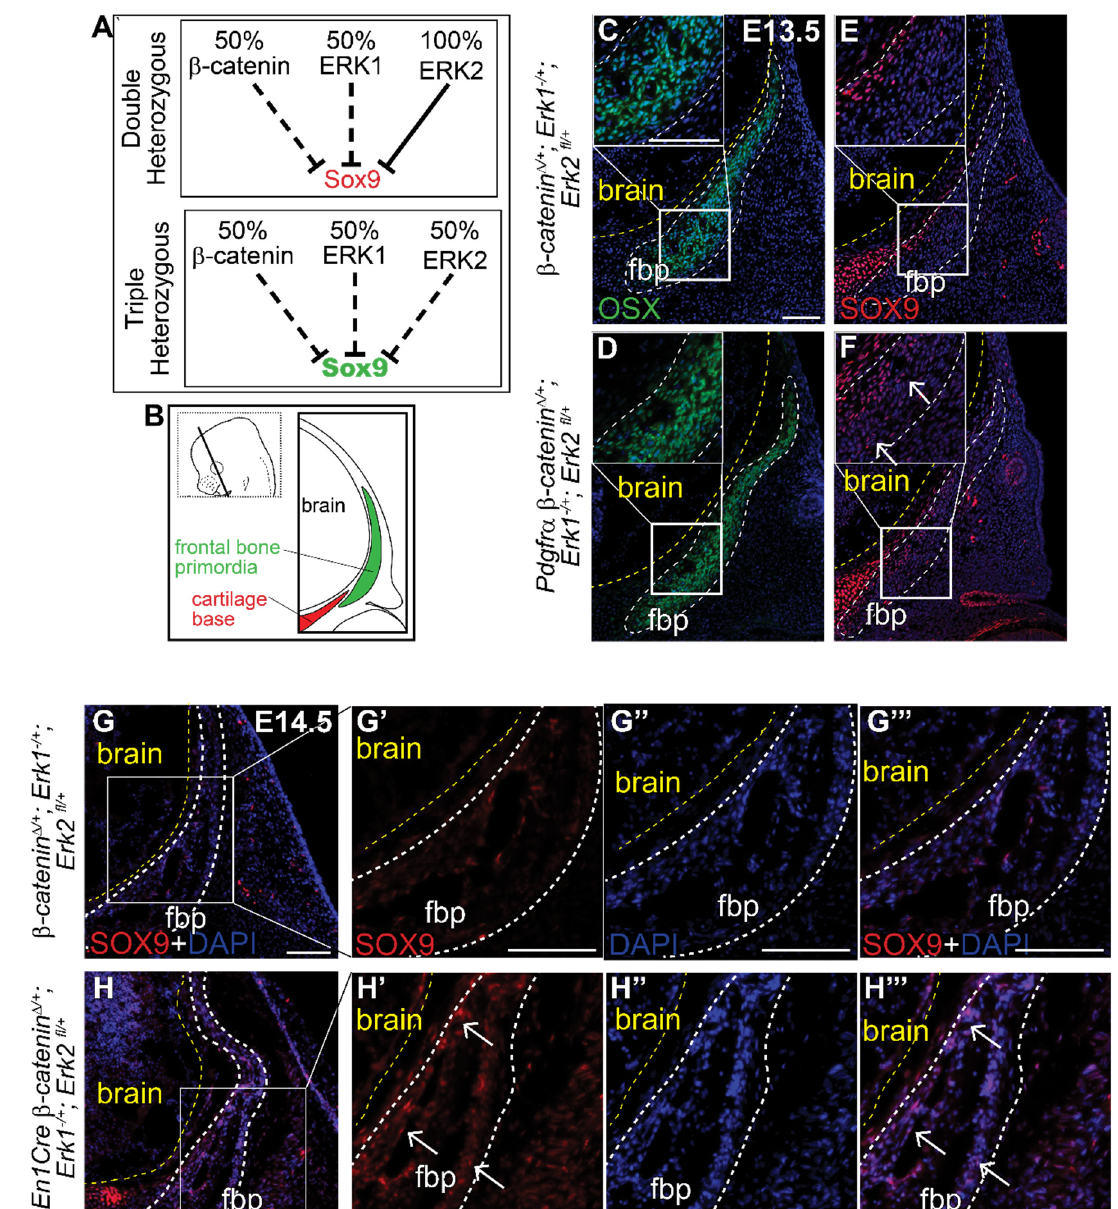
Figure 5. Triple heterozygous β - catenin ; Erk1/2 mutants demonstrate genetic interaction between the Wnt and ERK signaling pathways in SOX9 transcription. ( A ) Schematic describing genetic interaction hypothesis between Wnt and ERK signaling pathways to repress SOX9. ( B ) Schematic illustrating coronal sections. Immunofluorescence of OSX ( C , D ) and SOX9 ( E , F ) at E13.5 in β -catenin ∆ /+ ; Erk1 − /+ ; Erk2 fl/+ and Pdgfr α β -catenin ∆ /+ ; Erk1 − /+ ; Erk2 fl/+ heterozygous embryos. Immunofluorescence of SOX9 at E14.5 in β -catenin ∆ /+ ; Erk1 − /+ ; Erk2 fl/+ and En1Cre β -catenin ∆ /+ ; Erk1 − /+ ; Erk2 fl/+ embryos ( G – H’’’ ). Yellow line demarcates brain, white dashed lines demarcate fbp and region of interest. Arrows identify ectopic SOX9 expression within the fbp. fbp, frontal bone primordia; n = 3.